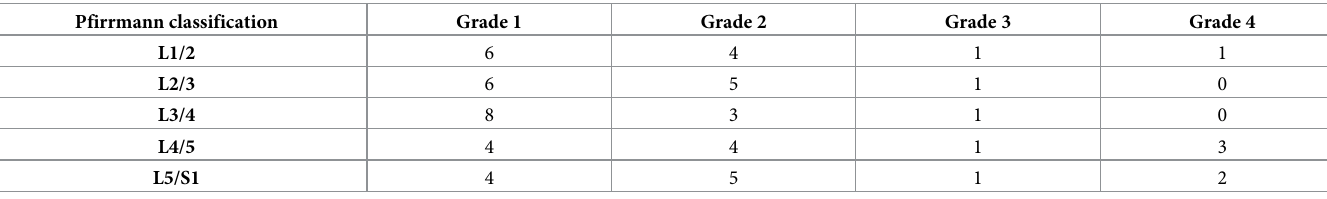
Table 3. Lumbar disc degeneration grade at each lumbar vertebral level in 2018, as defined by the Pfirrmann classification. Pfirrmann